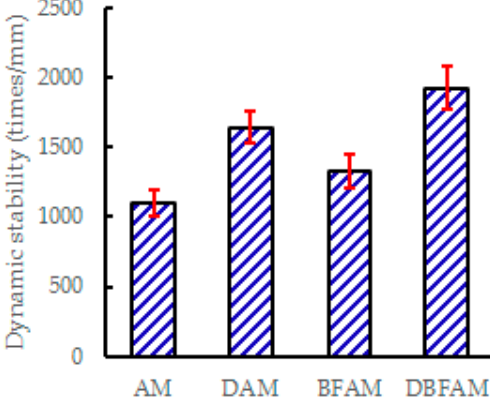
Figure 8. Dynamic stability of asphalt mixtures.